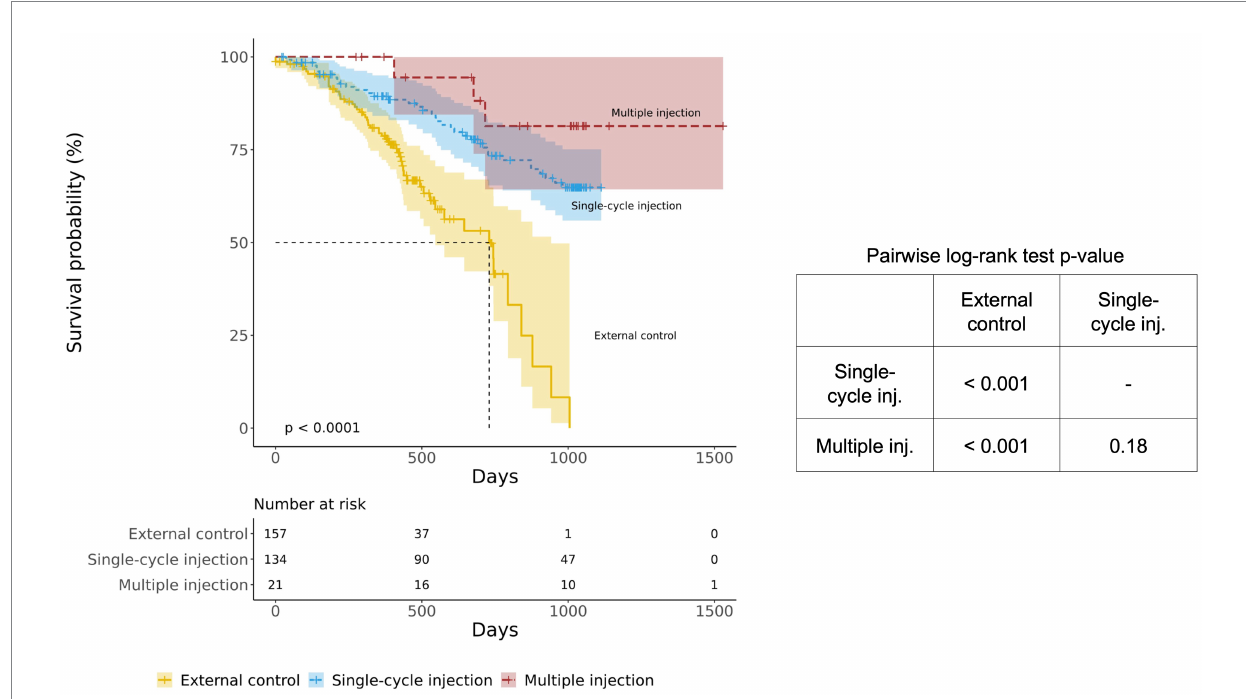
FIGURE 3 Kaplan–Meier survival curves of the BM-MSC treatment group (single-cycle injection and multiple injections) and the external control group. The BM- MSC group was divided into single-cycle injection (blue) and multiple-injection (red) groups and compared with the external control group